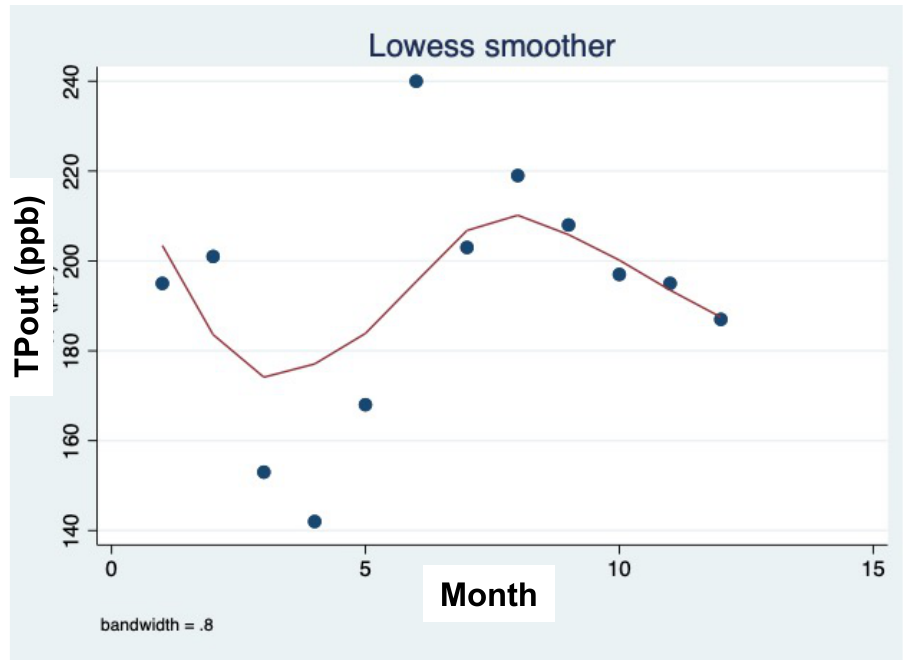
Figure 15. Monthly average (1993–2020) TP concentrations (ppb) in Agmon-Hula effluent. Scatter plot and LOWESS Smoother (bandwidth